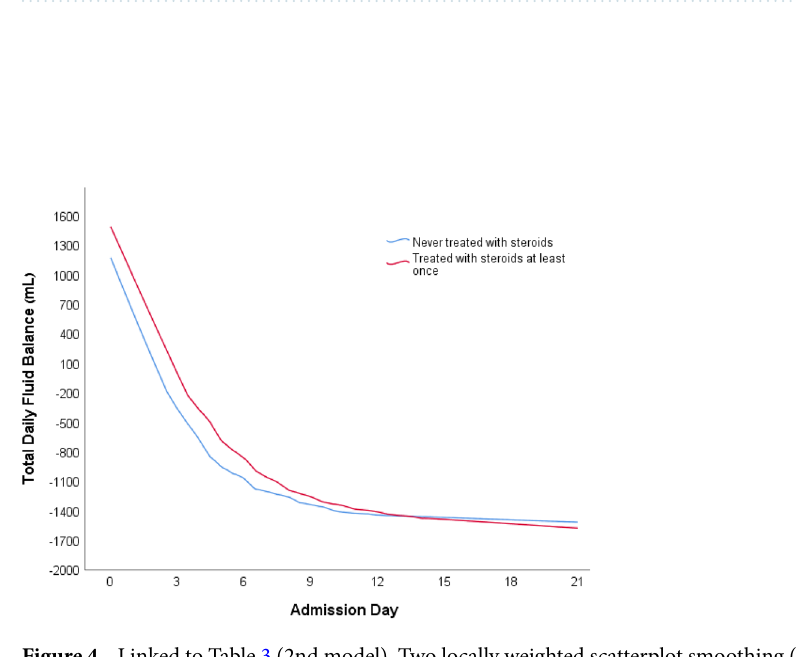
Figure 4. Linked to Table 3 (2nd model). Two locally weighted scatterplot smoothing (LOWESS) curves of the fluid balance in ml throughout the admission